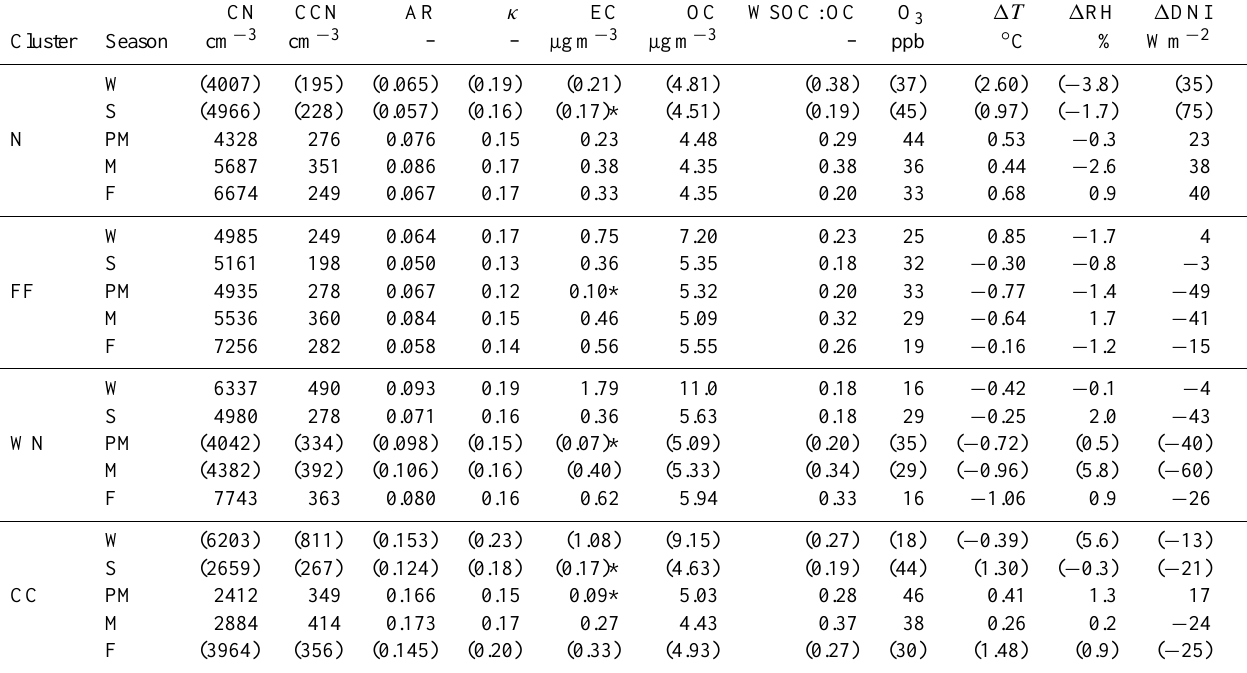
Table 3. Seasonally derived mean cluster properties and associated environmental conditions (AR is activation ratio). Meteorological vari- ables ( T , RH and direct normal irradiance, DNI) are presented as anomalies, based on departure from hourly means for each month. Entries in parentheses indicate that the cluster occurs less than 15% of the time in that season. An asterisk (*) next to EC denotes a case when the concentration is below LOD. O 3 data are obtained from a surface pollutant monitoring site ( ∼ 9km from TACO) operated by the Pima County Department of Environmental Quality (Children’s Park